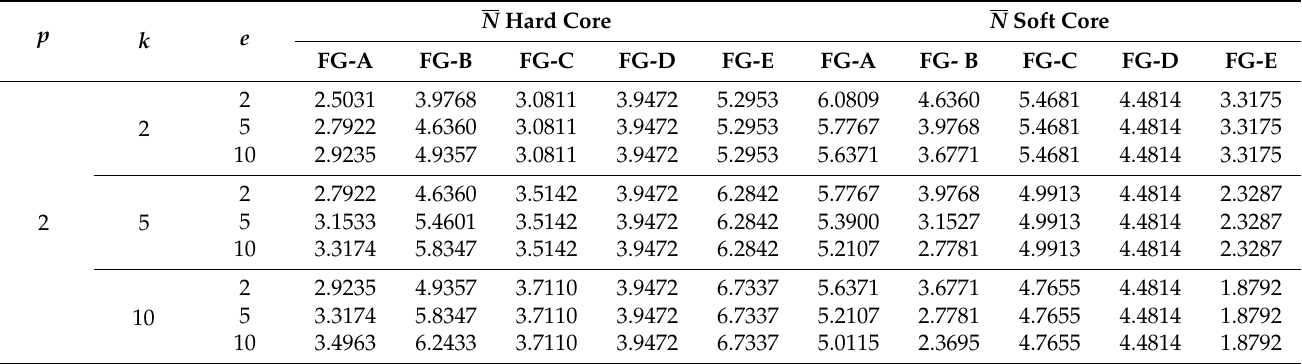
Table 3. Dimensionless critical buckling load N of FG shells versus exponents p , k , and e